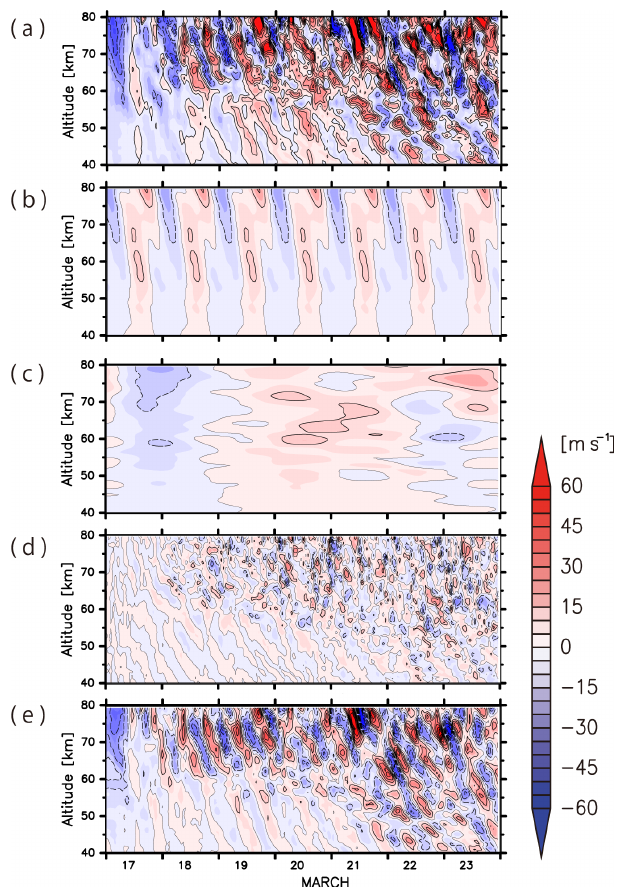
Figure 7. Time–altitude cross sections of (a) anomalies of the zonal wind components from the time–mean components, (b) the diurnal and semidiurnal migrating tidal components, (c) the planetary wave components, (d) small-scale gravity waves and (e) the remaining components. The contour intervals are 10ms − 1 . The data are from the NICAM simulation.